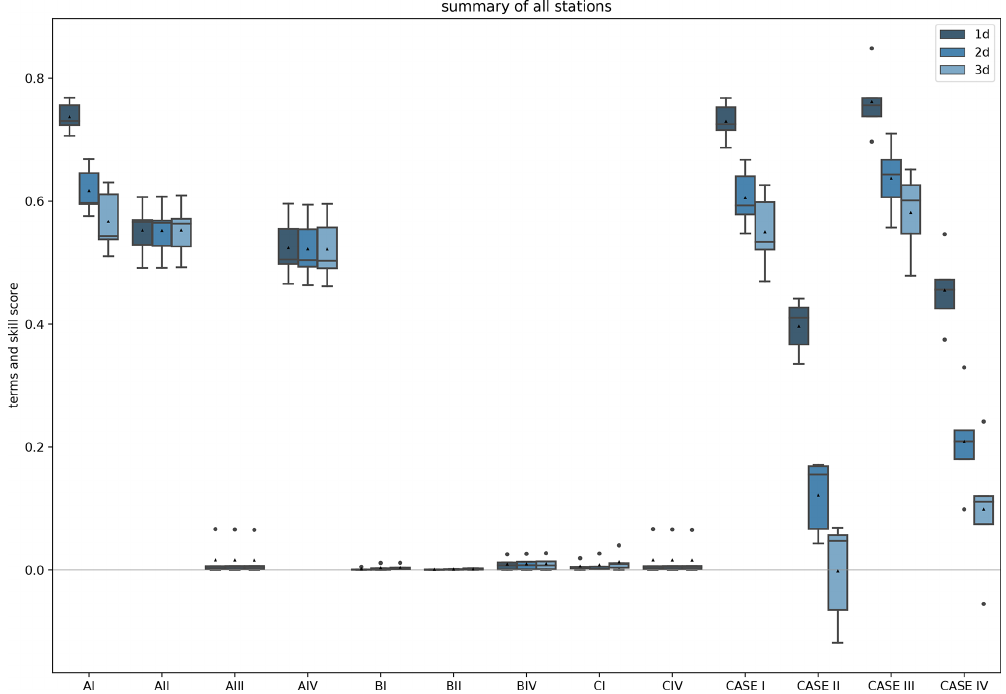
Figure 12. Climatological skill scores (cases I to IV) and related terms of the decomposition as proposed in Murphy (1988) created by PlotClimatologicalSkillScore . Skill scores and terms are shown separately for all forecast steps (dark to light blue). In brief, cases I to IV describe a comparison with climatological reference values evaluated on the test data. Case I is the comparison of the forecast with a single mean value formed on the training and validation data and case II with the (multi-value) monthly mean. The climatological references for cases III and IV are, analogous to cases I and II, the single and the multi-value mean, but on the test data. Cases I to IV are calculated from the terms AI to CIV. For more detailed explanations of the cases, we refer to Murphy (1988). Table 1. Summary of all parameters related to the host system that are required, recommended, or optional to adjust for a custom experiment